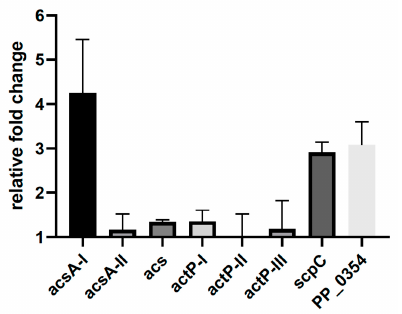
Figure 4. Analysis of the relative expression of genes related to acetate metabolism. Gene expression was analyzed by qRT-PCR in P. putida KT2440 (WT) grown in minimal medium with acetate in comparison to growth succinate as sole carbon source. The measurements were performed a minimum of three times.